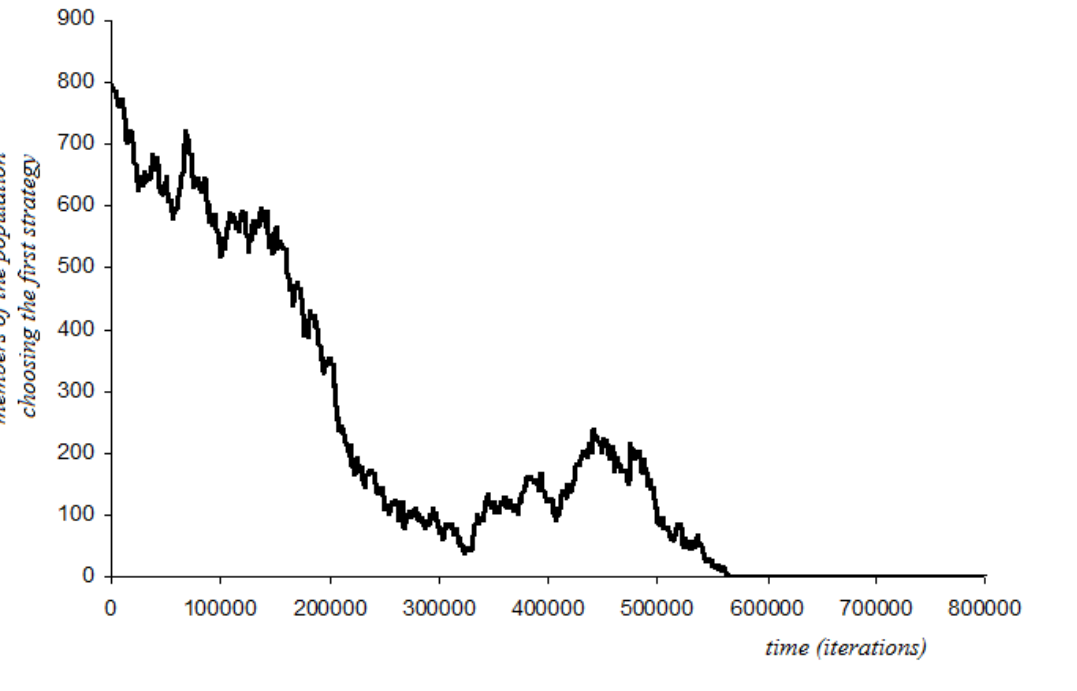
Figure 4. ‘ Stag-Hunt #3’ when 50% of players are, initially, drawn to the efficient outcome. When 50% of them are intruders the efficient outcome is guaranteed (Series